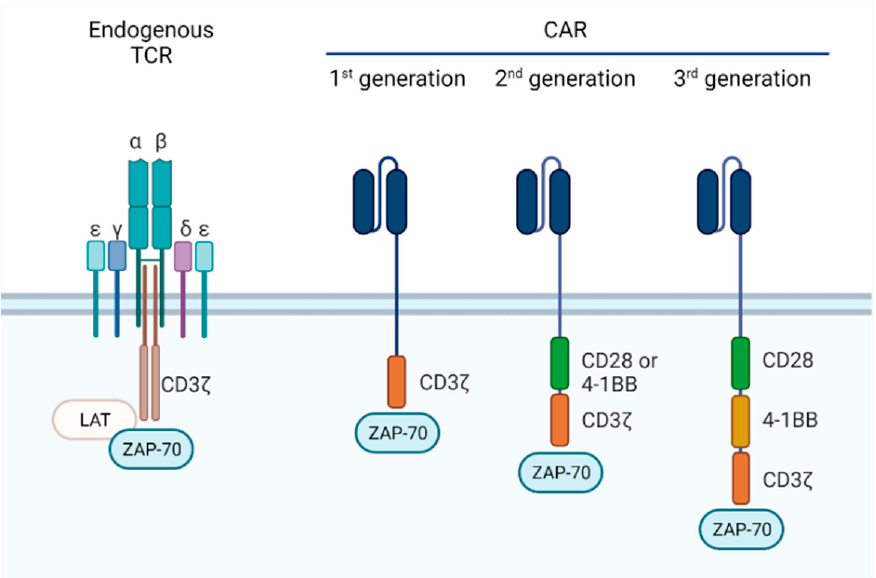
Figure 3. Schematic overview of the CAR design through multiple generations. On the left side of the figure, the endogenous TCR is depicted together with the proximal interacting signaling molecules (LAT: linker of activation and ZAP70). On the right side of the figure, the different successive generations of the CAR design are depicted. CAR domains: blue domain: antigen recognition domain; green domain: costimulatory domain; orange domain: CD3 ζ signaling domain.